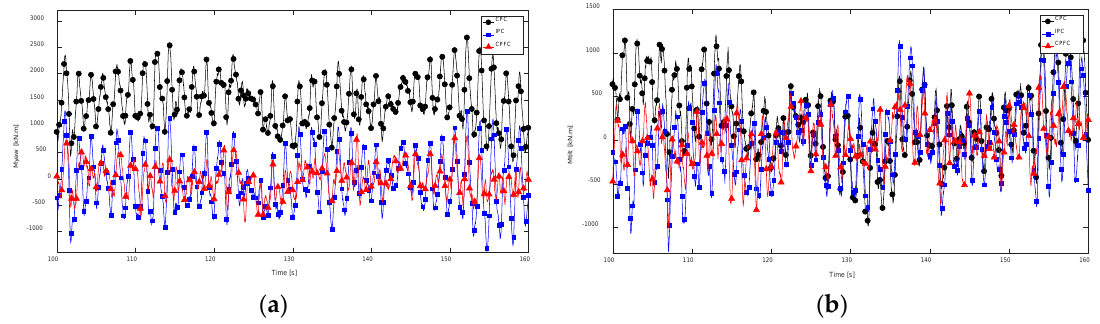
Figure 7. The yaw moments and tilt moments in hub frame. ( a ) The yaw moments; ( b ) The tilt moments. Table 3. the Standard deviation of blade root bending moment and tip deflection.